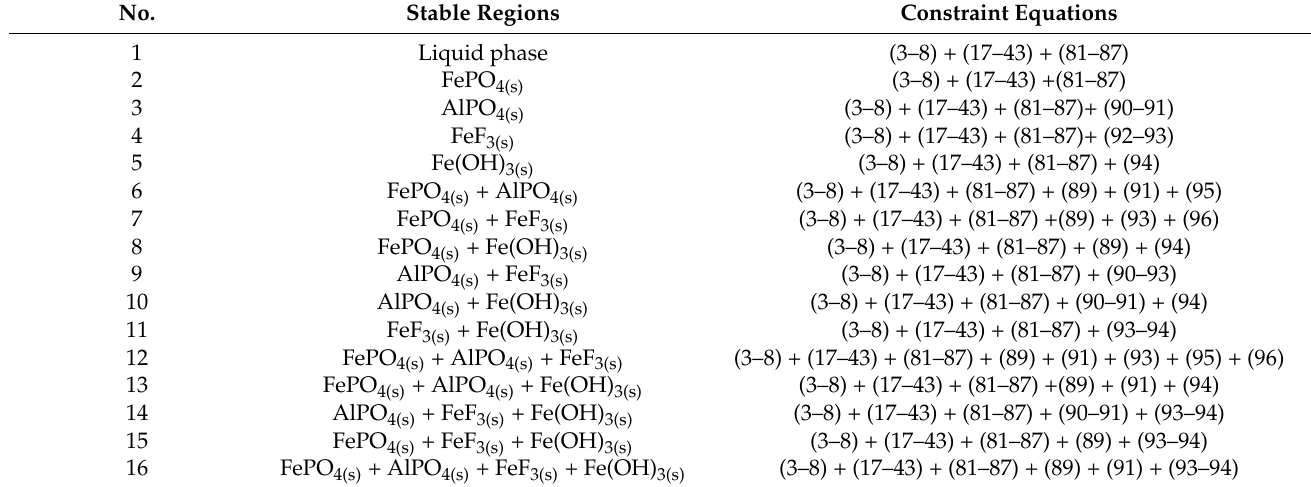
Table 8. Possible stable regions of Li + –Fe 3+ –Al 3+ –PO 43 − –SO 42 − –F − –H 2 O system and their corresponding constraint